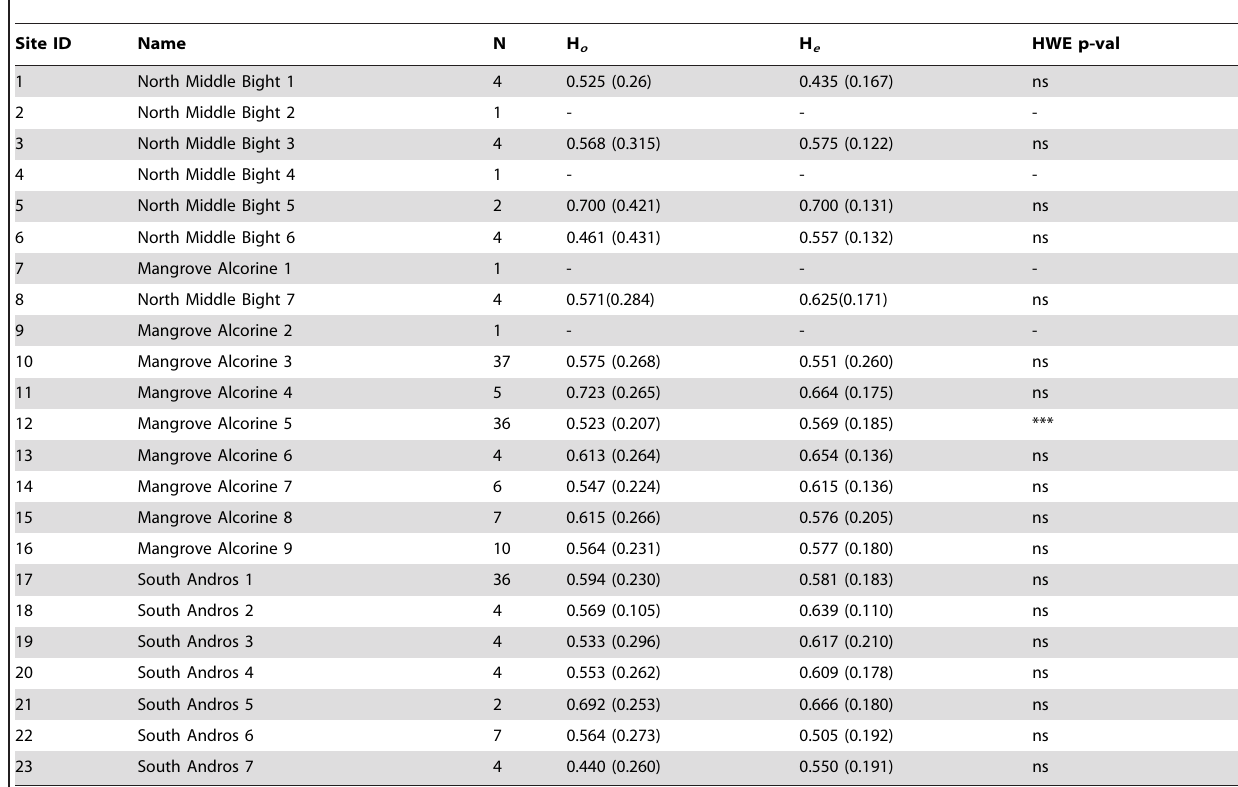
Table 1. Sampling site